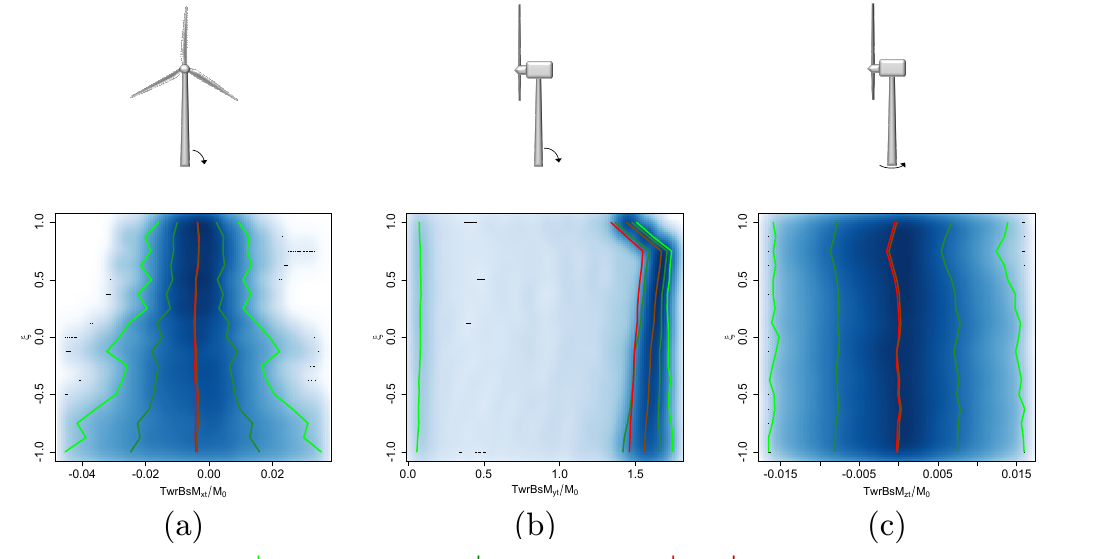
Figure 8. Variation with ξ of the PDFs of the tower base’s moments. (a) Bending in the plane of rotation. (b) Bending across the plane of rotation. (c) Torsion. The parameter ξ is represented by the vertical axis, starting with an entirely positive shear at the bottom (where ξ = − 1) and ending with an entirely negative shear at the top (where ξ = 1). The horizontal axis represents values of the tower base’s moments (TwrBsM) normalized by a reference ( M 0 ). The background color is deeper where values are more concentrated. The red line and the dark red line connect the mean and the median values, respectively. The green lines and the dark green lines delimit the zones encompassing 95 and 68% of the values,